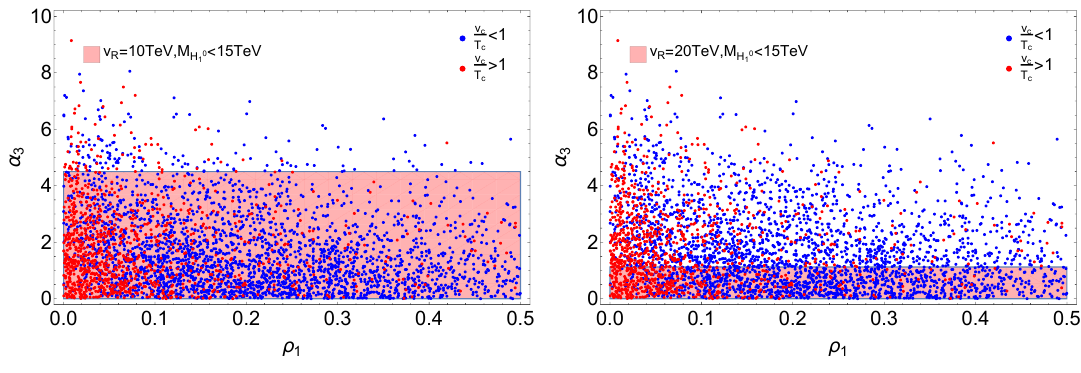
Figure 3 . Scatter plots of ρ 1 and α 3 , with the blue points have v c /T c < 1 and the red ones v c /T c > 1 . In the left panel, the FCNC limits on α 3 for v R = 10 TeV and M < 15 TeV are H 0 1 indicated by the pink shaded regions. In the right panel, the case with v = 20 TeV is shown. R survive and have strong FOPT. When the v scale is higher, say v = 20 TeV, the quartic R R coupling α is significantly smaller, i.e. α > 1 . 13 . The region denoted by the light pink 3 3 shaded region in the right panel of figure 3 is excluded. Then there will be more points that can have a strong FOPT with v /T > 1 , as clearly shown in the right panel of figure c c